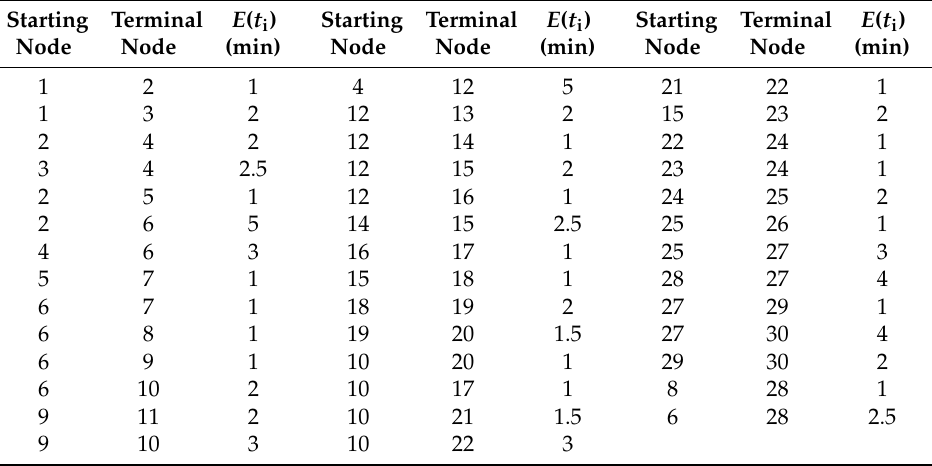
Table 2. The expectation of operation time for each line.